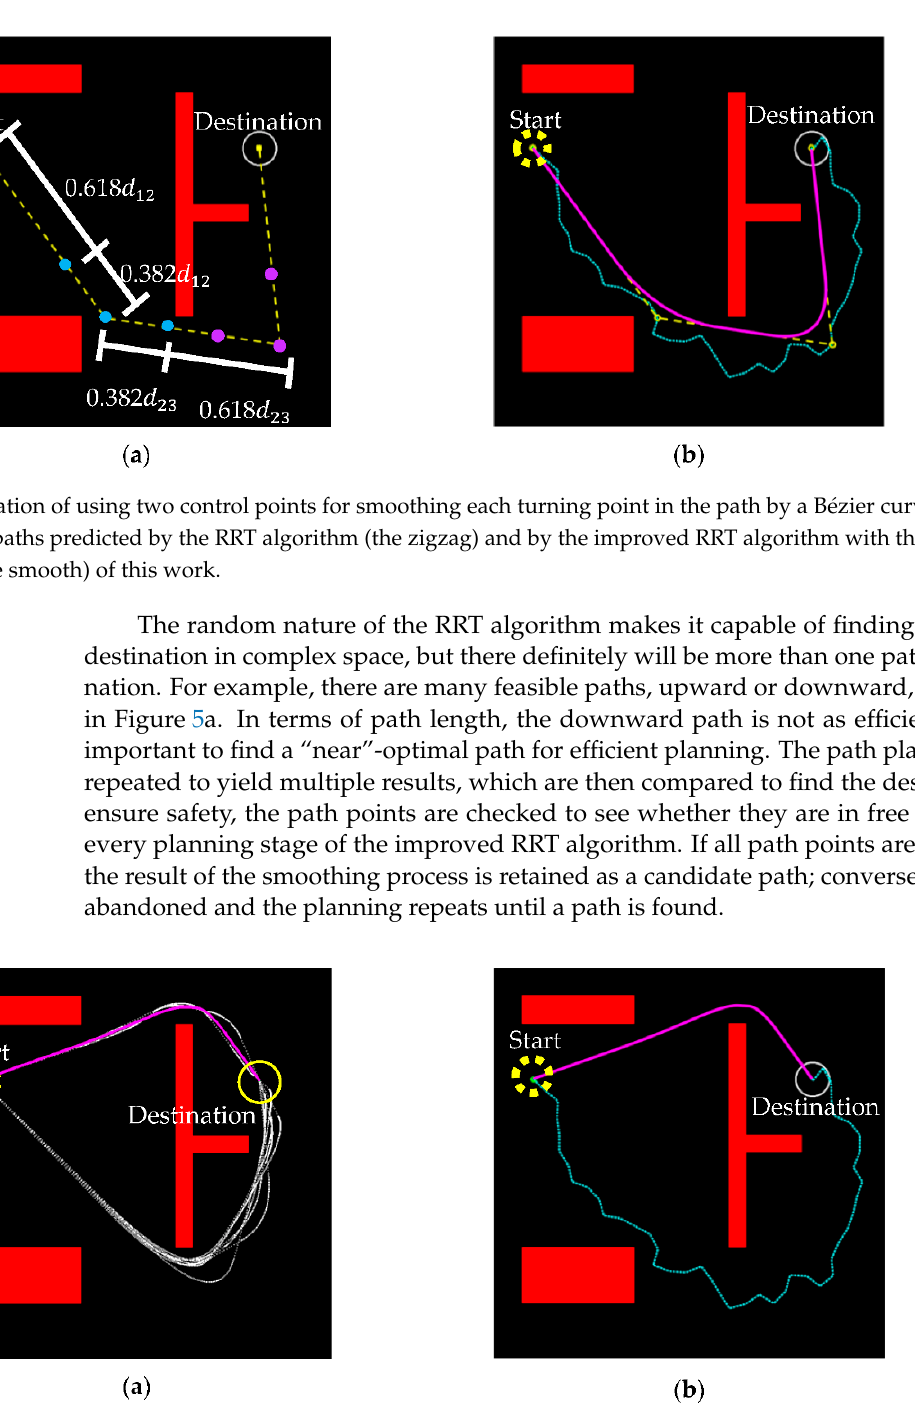
Figure 5. ( a ) The result of the improved RRT algorithm in planning of 10 paths during optimiza- tion, and ( b ) among the 10 paths, the one in the shortest path (solid line) is much more efficient than the path taken by the RRT algorithm (dot line) in reaching the destination.